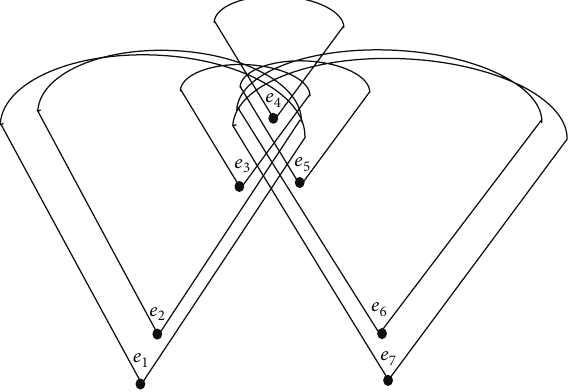
Figure 8: A V-formation: entities 𝑒 1 and 𝑒 7 would require a wide front region in order to contain the entity leader 𝑒 4 .